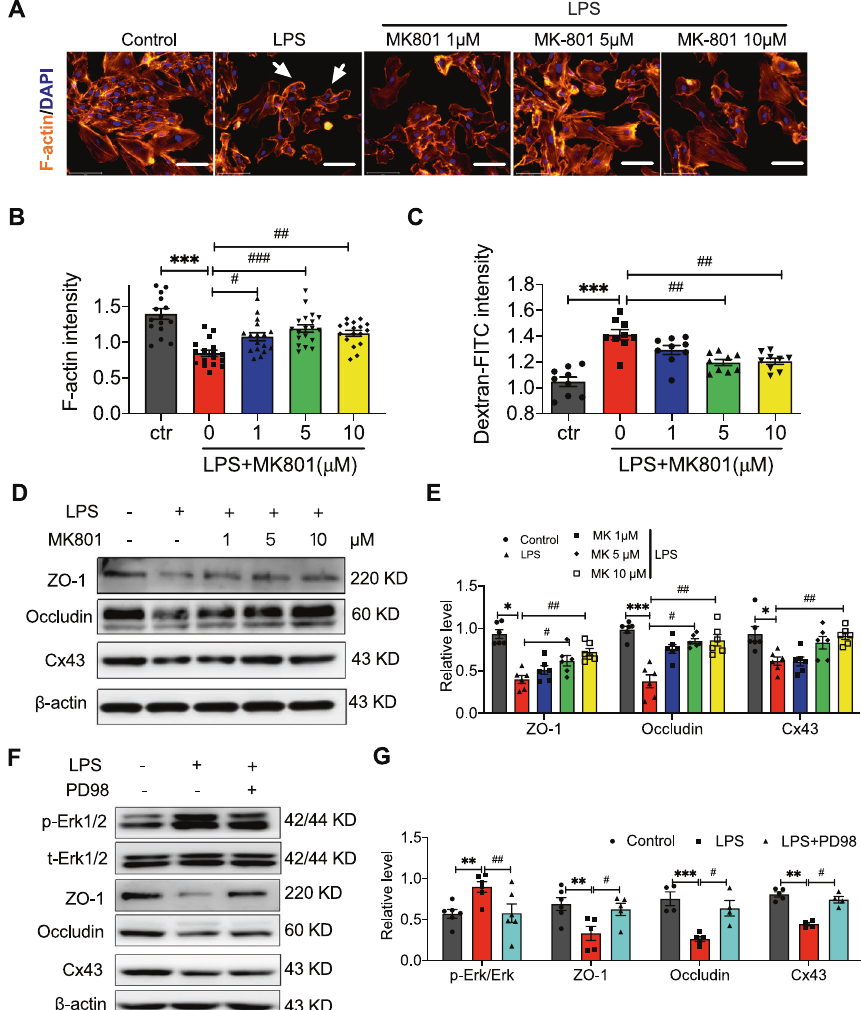
Fig. 4 MK801 rescued LPS-increased permeability in HUVECs. A Immunostaining images of F-actin labeled with TRITC Phalloidin and B analysis in HUVECs induced by LPS and treated with MK801; the peripheral bands of F-actin and intercellular gaps appeared between adjacent cells. C Vascular Permeability Assay showed the relative intensity of FITC-Dextran in HUVECs induced by LPS and treated with MK801. Representative of western blotting images ( D ) and analysis ( E ) of expression of ZO-1, Occludin, and Cx43 in LPS-exposed HUVECs in